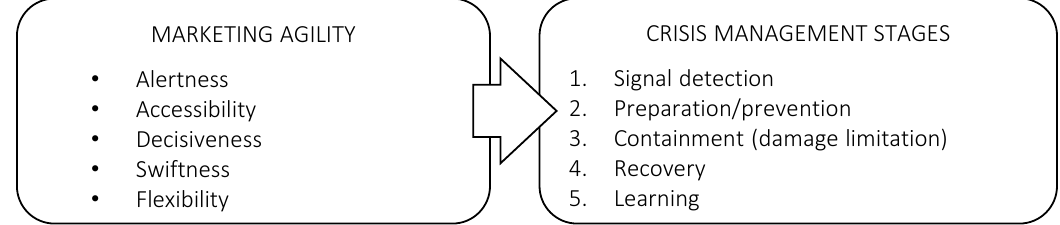
Figure 1. Theoretical